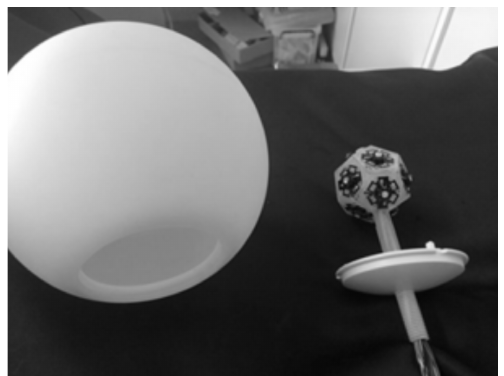
Figure 9. The light source mounted on the Opt-copter is con- sisted of 12 UV-LEDs attached on dodecahedron and a spherical di ff user